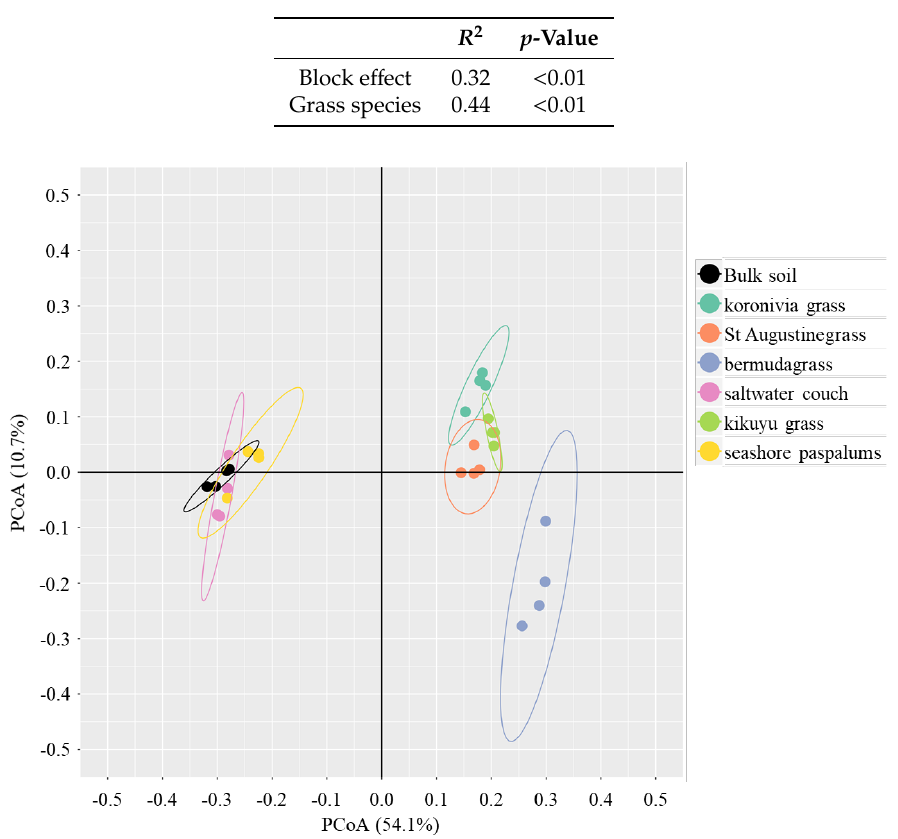
Figure 2. Microbiome composition in the bulk soil and rhizosphere soil of six perennial grasses. Unconstrained principal coordinate analyses (PCoAs) were performed based on the Bray–Curtis distance between samples using amplicon sequence variant (ASV) as the taxonomic unit. Ellipses indicate 95% confidence level to cover all the samples in each treatment.